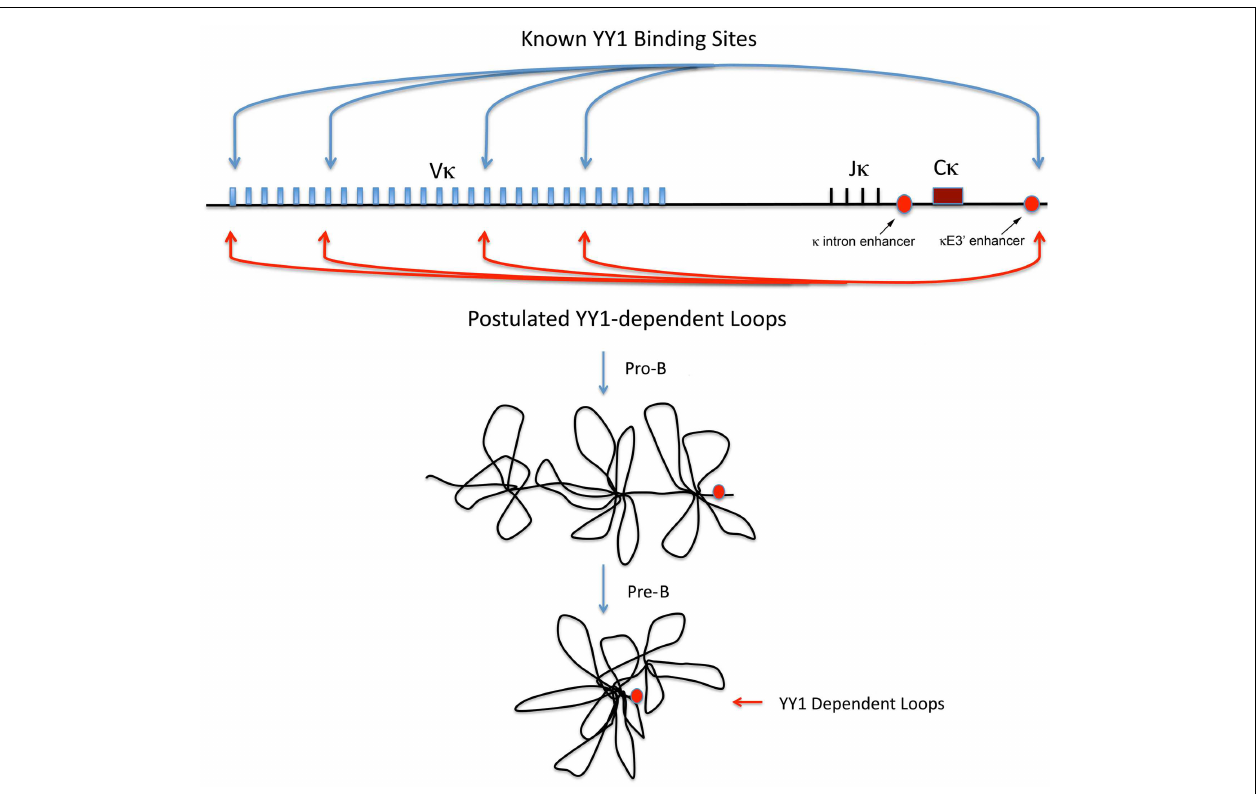
FIGURE 3 | Ig κ locus diagram showing the location of knownYY1 binding sites, and the postulatedYY1-dependent loops required forV κ –J κ rearrangement . Locations of the Ig κ intron and κ E3 (cid:48) enhancers and shown by red circles and arrows. Postulated locus structure in pro-B and pre-B cells is show